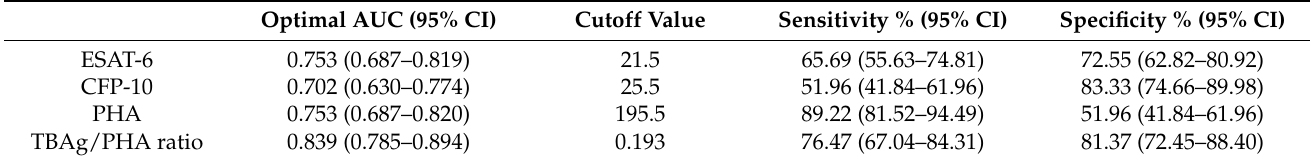
Table 2. The optimal AUC of different indicators in T-SPOT results in differentiation between before and after successful